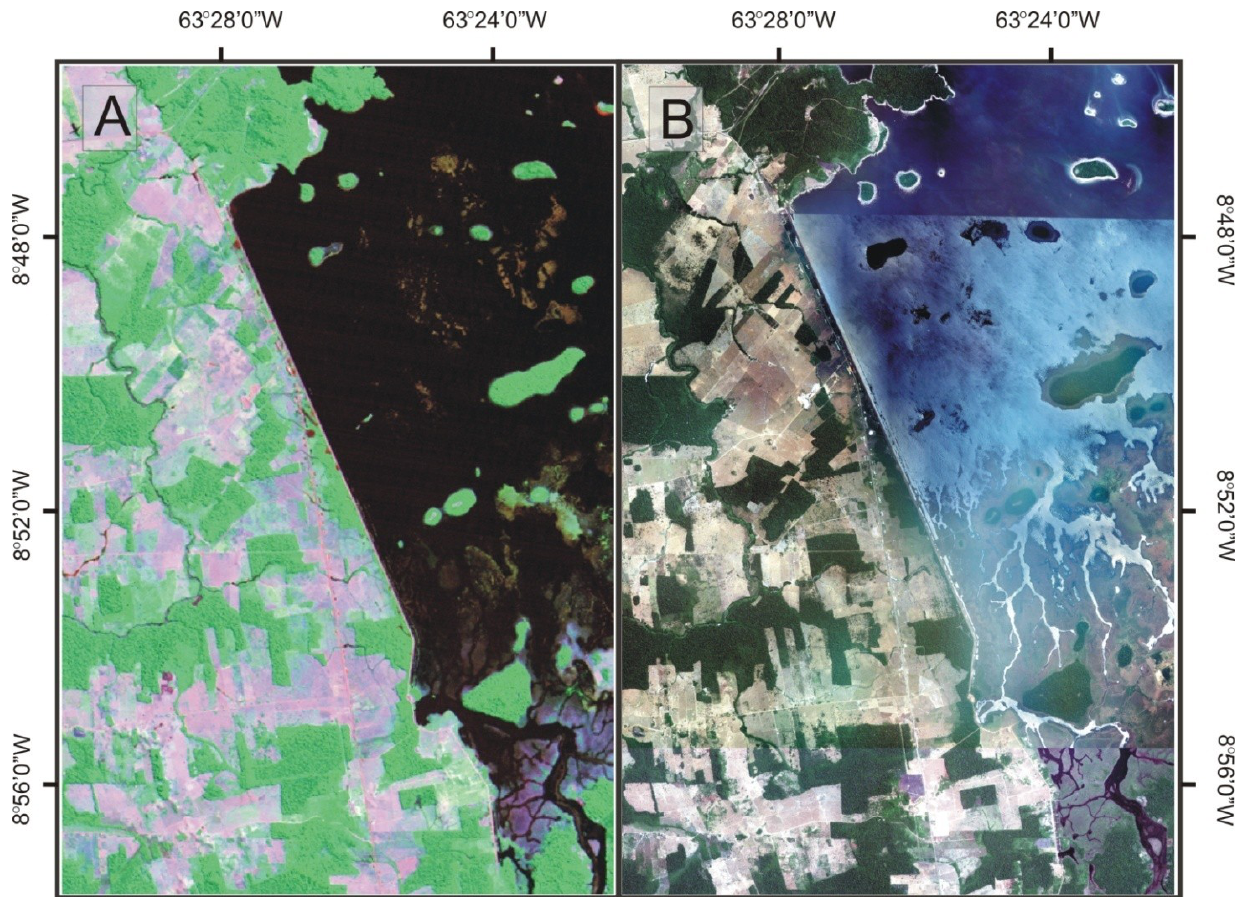
Figure 4. ( A ) TM/Landsat-5 image on 15 July 2009, color composite 345 (RGB) and ( B ) high-resolution imagery archives from Google